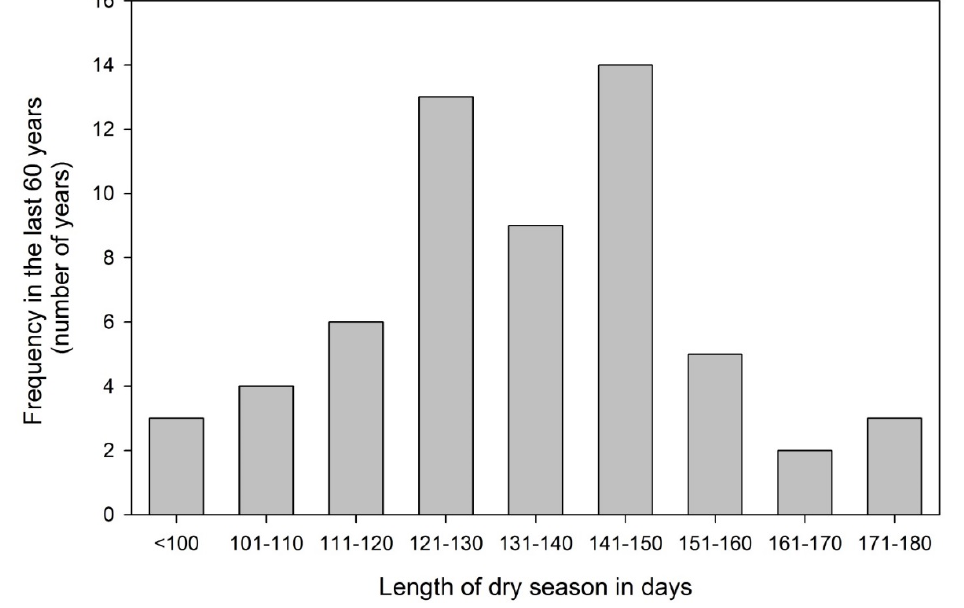
Figure 1. Frequency of dry season length in Panama since 1954. Average dry season length is 131 ± 19 days in an annual cycle (data from Paton [43]). Note: Dry seasons over 171 days in length are El Niño years in 1976, 1982 and